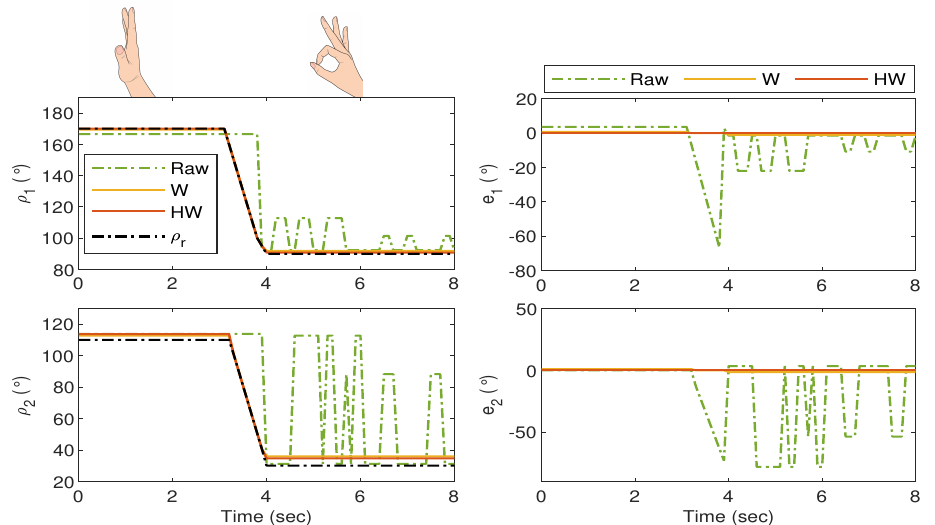
Figure 20. Gesture 4: The mismatch between the glove’s and bionic hand’s goniometry is significantly reduced when both Compensators W and HW are applied.